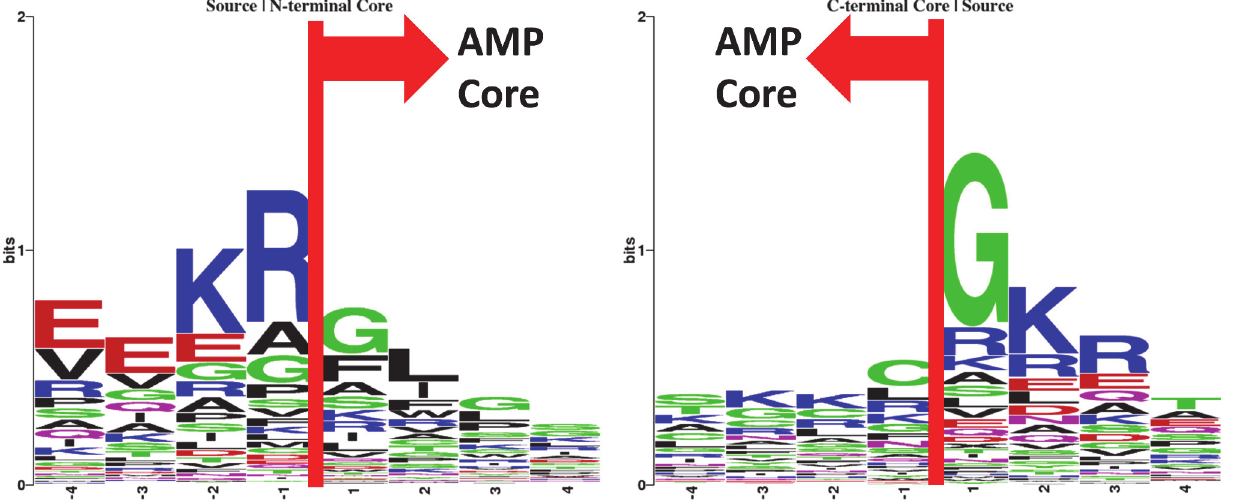
Fig 8. Sequences logos of the boundaries of the N-terminal and C-terminal AMP critical regions.